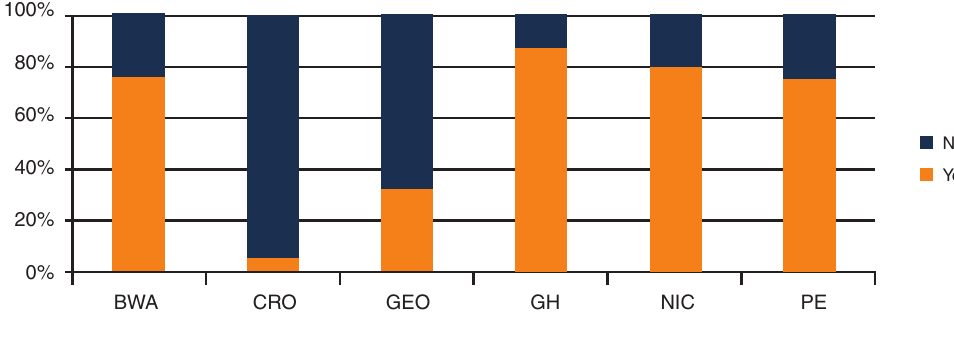
FIGURE 15. Distribution of “Simulated Self-Referred Patient” Visits That Ended with Dispensation of an Antimicrobial, by